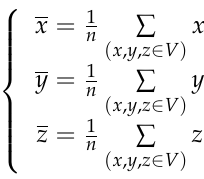
where n is the total number of points in the voxel V .